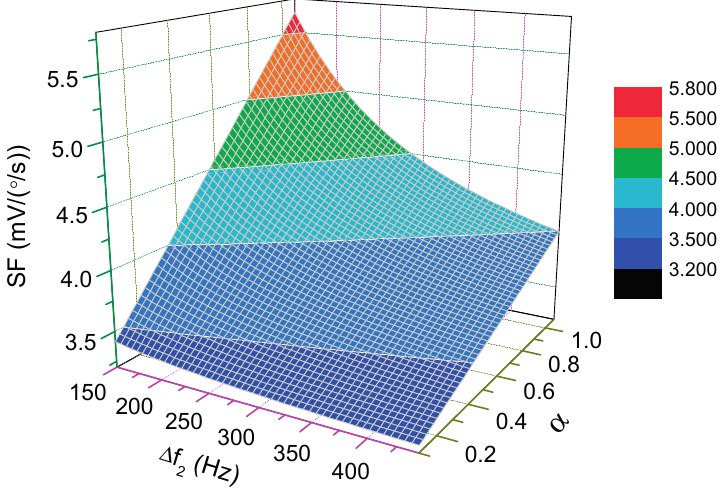
Figure 8. The change of scale-factor with variations of ∆(cid:2033)